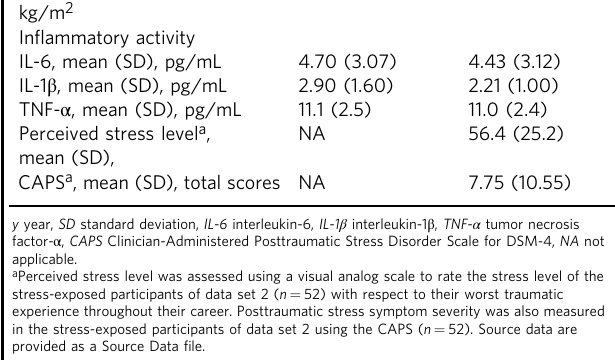
connection clusters (Fig. 3b; Supplementary Table 3). A similar pattern of between-group difference was observed in the data- driven clustering approach for inter-network clusters 3, 4, and 5 (Fig. 3b; Supplementary Table 3).